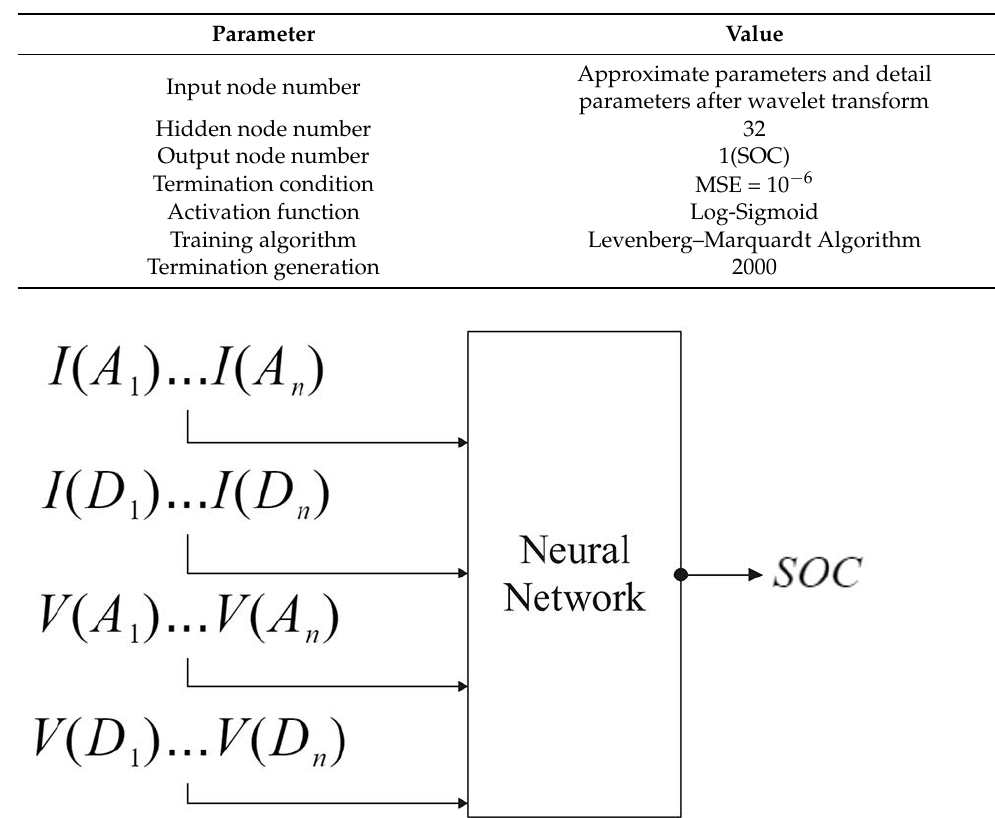
Figure 6. SOC estimation